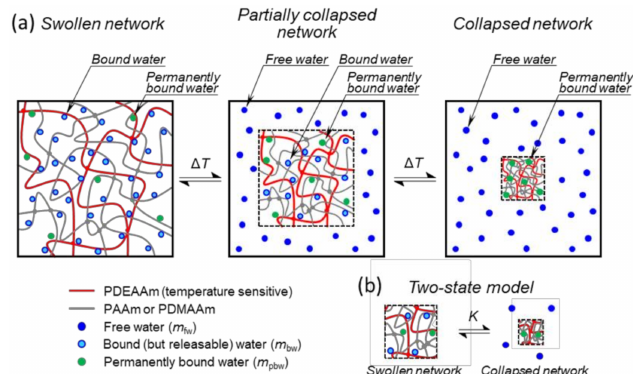
Figure 1. ( a ) Schematic model of temperature-dependent deswelling experiment of SN and double network (DN) networks (the figure shows an actual model of DN). The entire system is shown, and dashed-line squares denote the boundary of the polymer network during the collapse. ( b ) Two-state swollen-collapsed network model with permanently bound